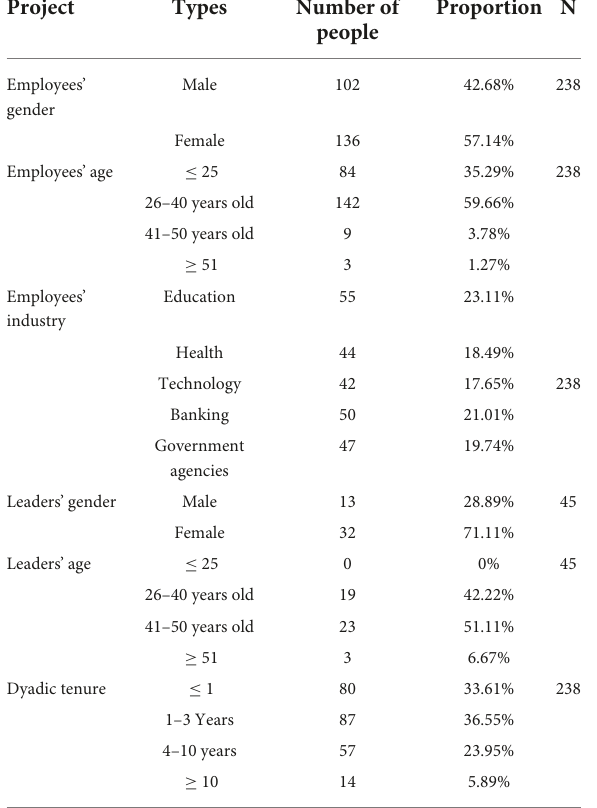
TABLE 1 Basic information of the